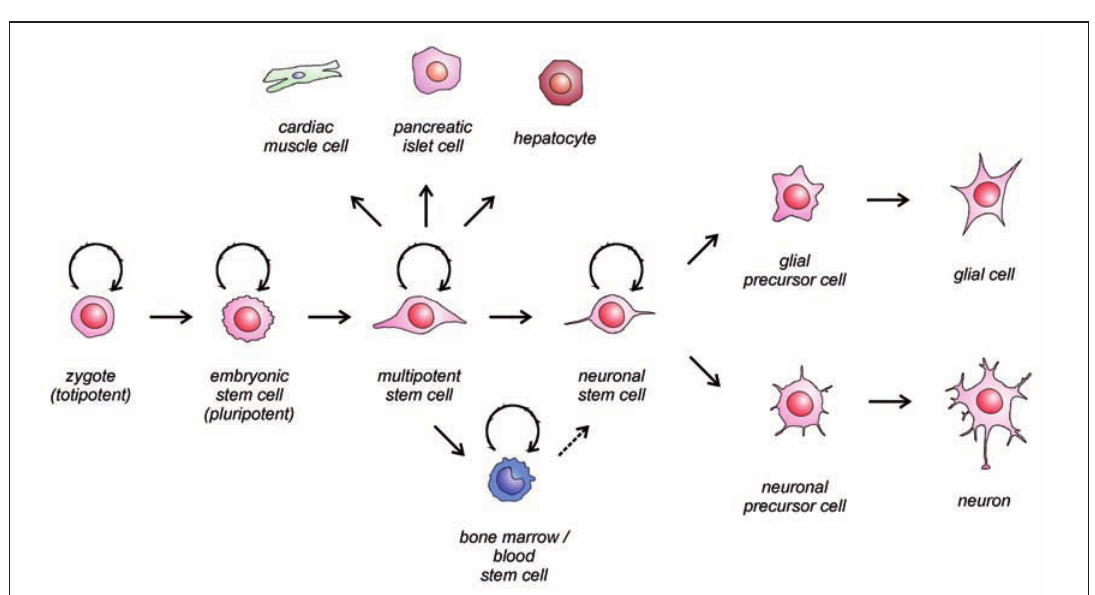
Diagram illustrating the potential for dif- ferentiation of stem cells. Embryonic stem cells can differ- entiate into almost all cells of our body. With ongoing matu- ration, their ability to differentiate into dif- ferent types of cells becomes more and more restricted. The differentiation capa- bility of neural stem cells is restricted to the neuronal and glial lineage. Bone marrow stem cells have the capability to transdifferentiate into neural stem cells (dashed arrow). Stem cells can proliferate indefinitely (self- renewal; circular arrows).